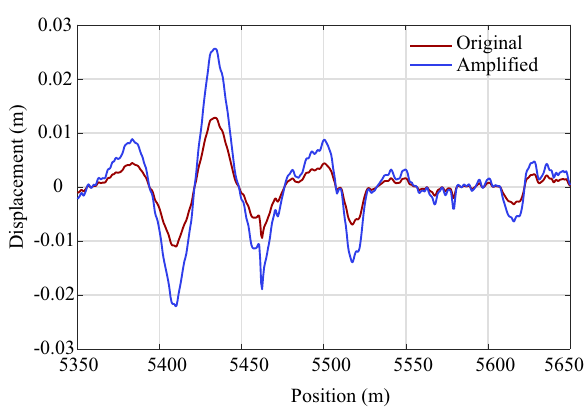
Fig. 13 Track displacement original and multiplied by two